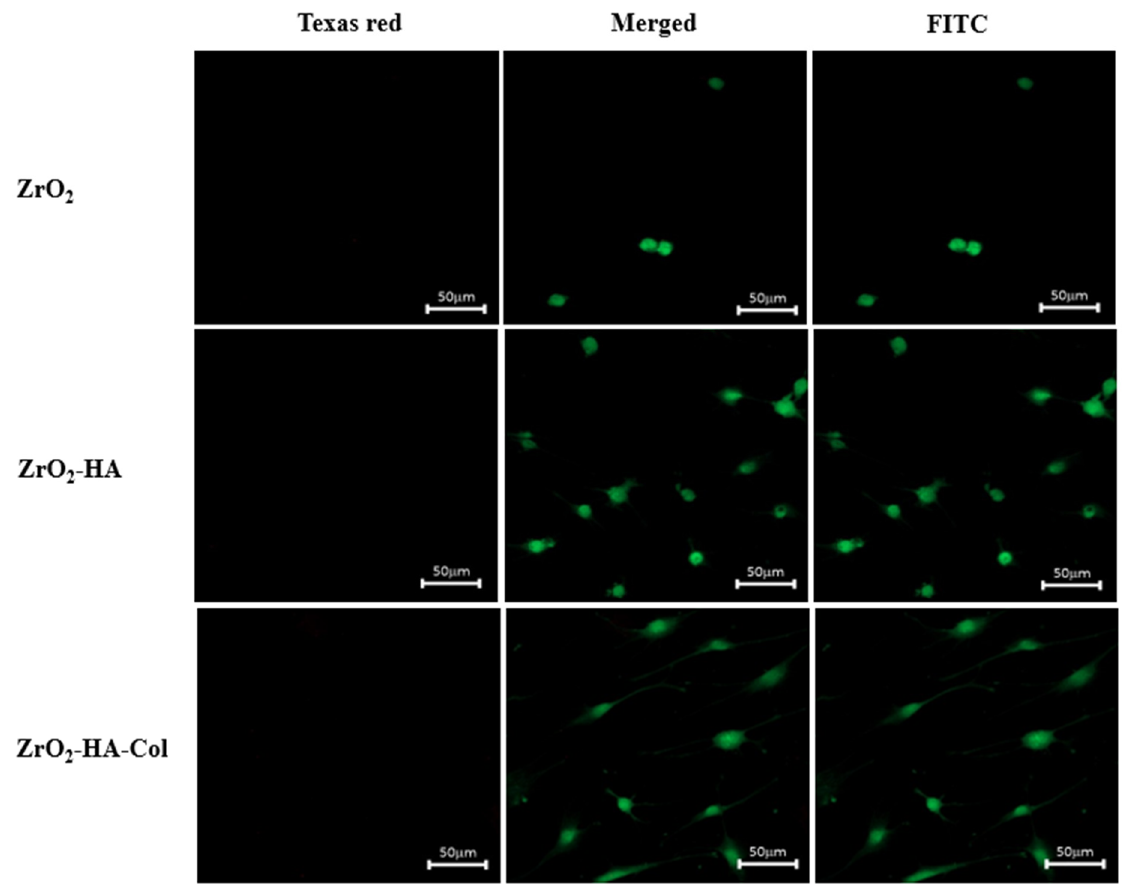
Figure 8. Confocal fluorescence microscopy images of osteoblasts cultured for 1 day on the ZrO 2 , ZrO 2 -HA and ZrO 2 -HA-Col. In order to investigate the cytotoxicity by the scaffold, confocal fluorescence microscopy images were examined by staining with Texas red and FITC. Dead cells are stained by Texas red and appear red, while living cells are stained by FITC and appear green.